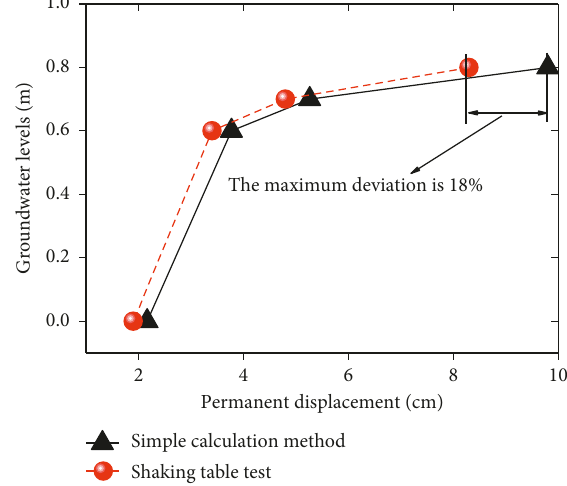
Figure 12: Permanent displacements of different